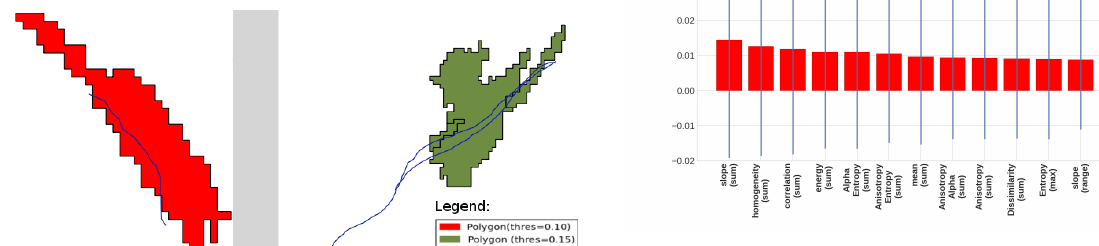
shown in Figure 4. Larger segments for the selected threshold